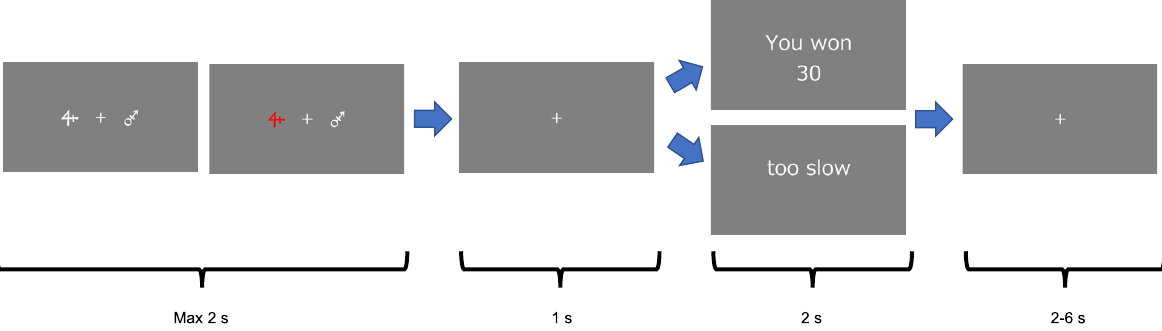
Figure 1. Schematic representation of the experiment. Participants chose one of the visual stimuli within 2 s. The colour of the selected stimuli turned red. Then the fixation cross was presented for 1 s, and feedback was displayed for 2 s. The next trial began after a variable interval of 2–6